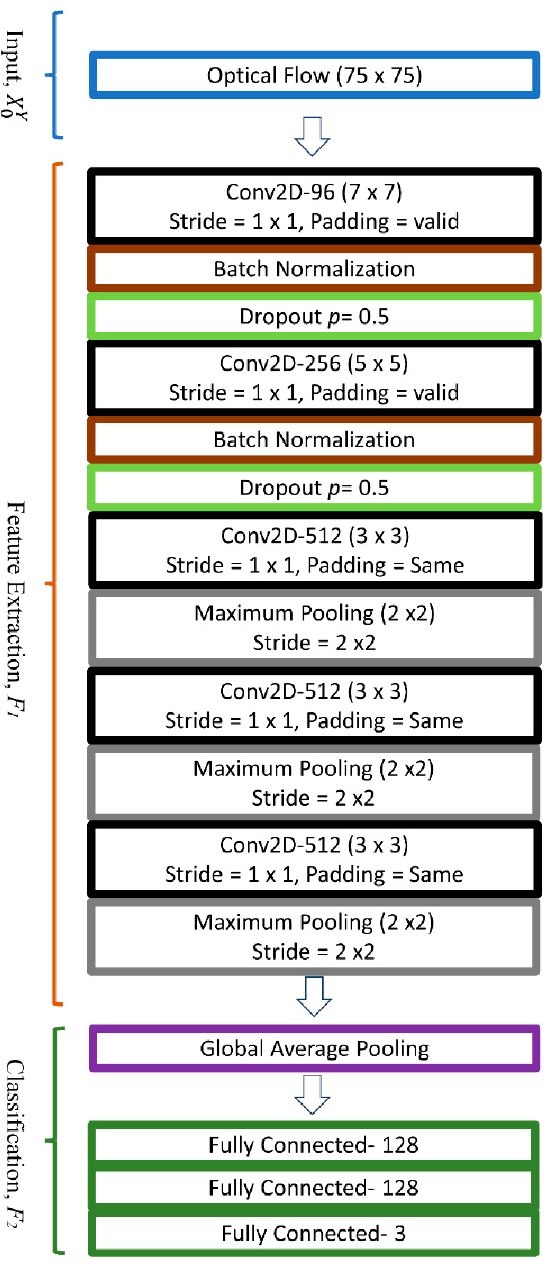
Figure 11. The proposed architecture of OC-Net that outputs 3 nodes of emotion class one-hot labels.